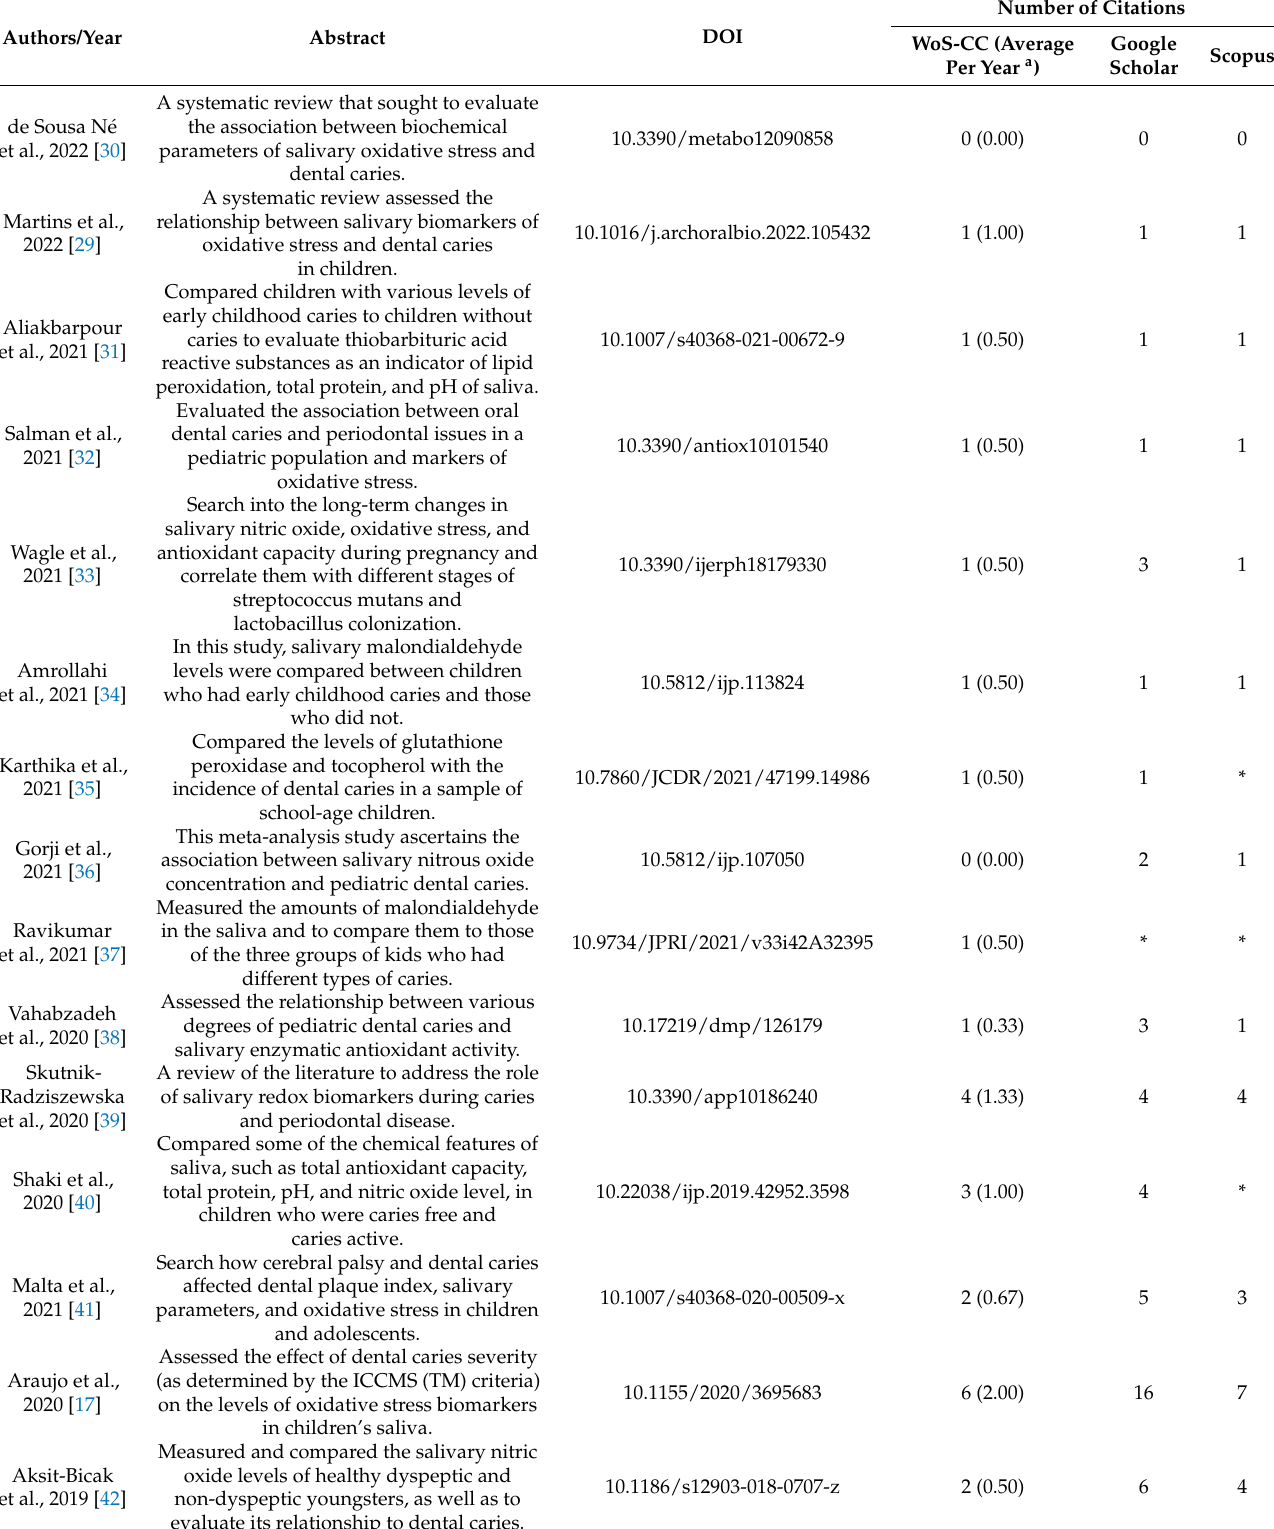
Table 1. The articles selected about the relationship between dental caries and salivary oxidative